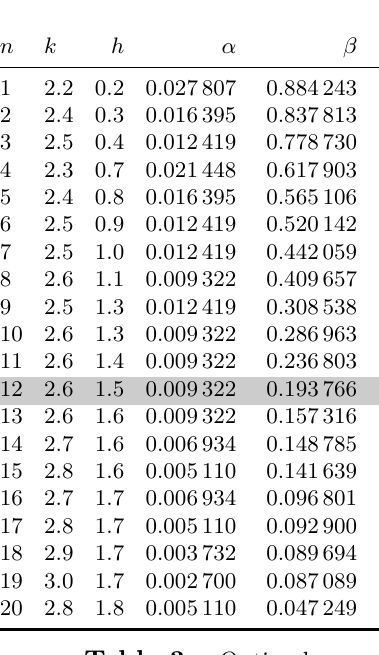
Table 3: Optimal economic statistical designs with ATS